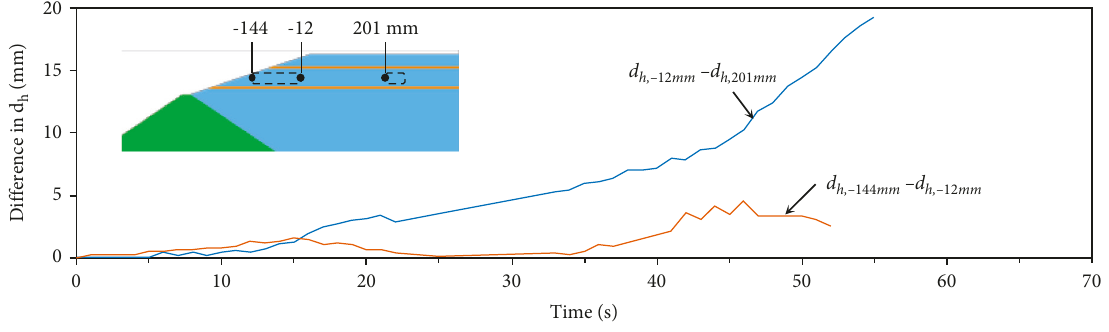
Figure 17: Evolutions of the relative displacements, i.e., d